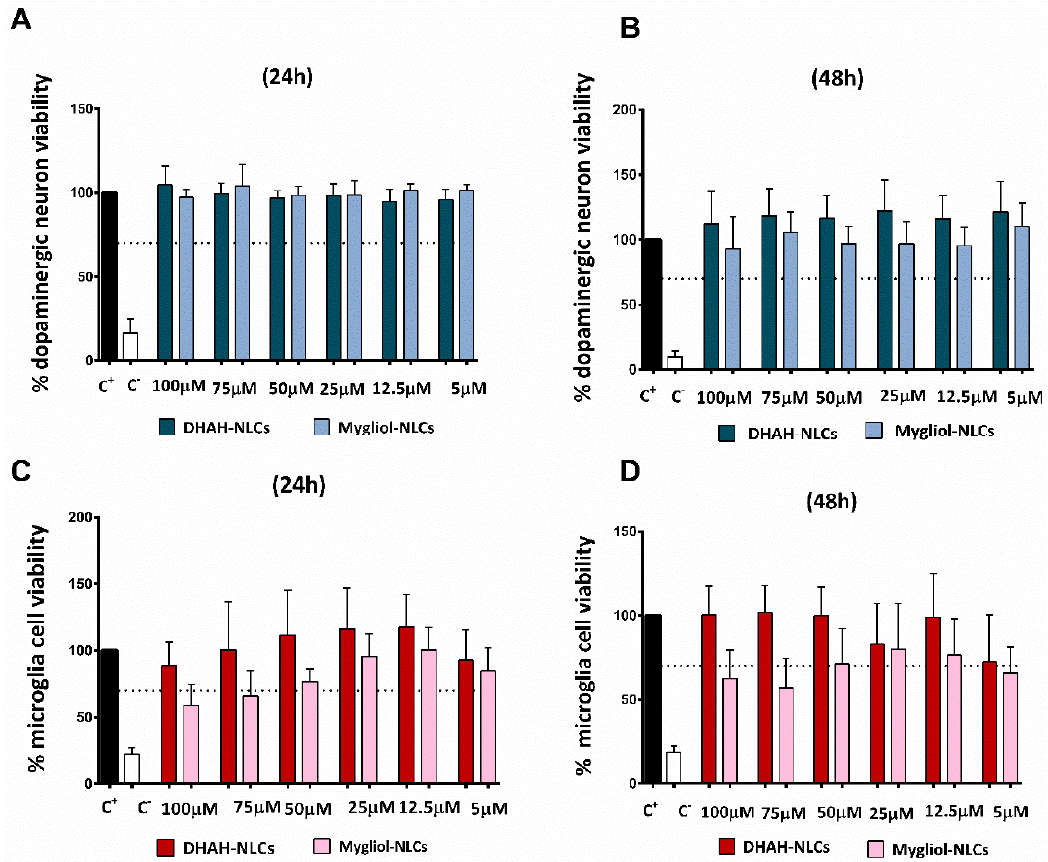
Figure 7. ( A ) Dopaminergic neuron viability at 24 h. ( B ) Dopaminergic neuron viability at 48 h. ( C ) Microglia cell viability at 24 h. ( D ) Microglia cell viability at 48 h. In all cases, different concentrations of DHAH-NLCs and Mygliol-NLCs were tested (the graphs show the results of three biological replicates media ± SD).